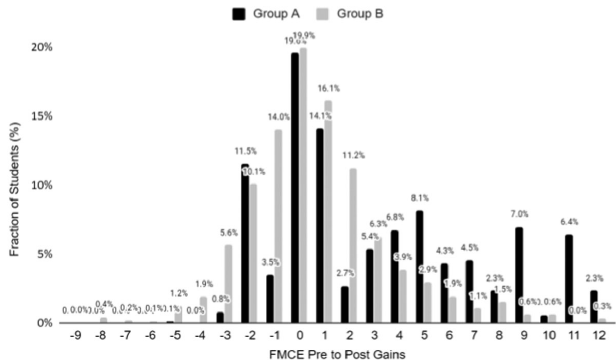
FIG. 1. The pre-to-post FMCE gains for students that reported working in small groups every class (group A) and students that did not (group